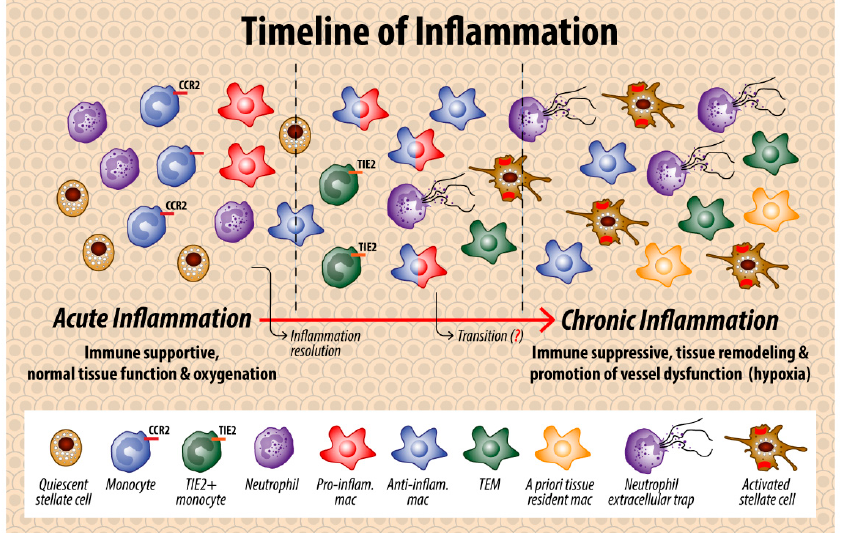
Figure 3. The timeline of inflammation during development of PDAC. Acute phases of inflamma- tion can be resolved, but the inflammation fails to be resolved in the PDAC environment. This chronic, unresolving inflammation leads to immunosuppression, tissue remodeling, and vessel dys- function.